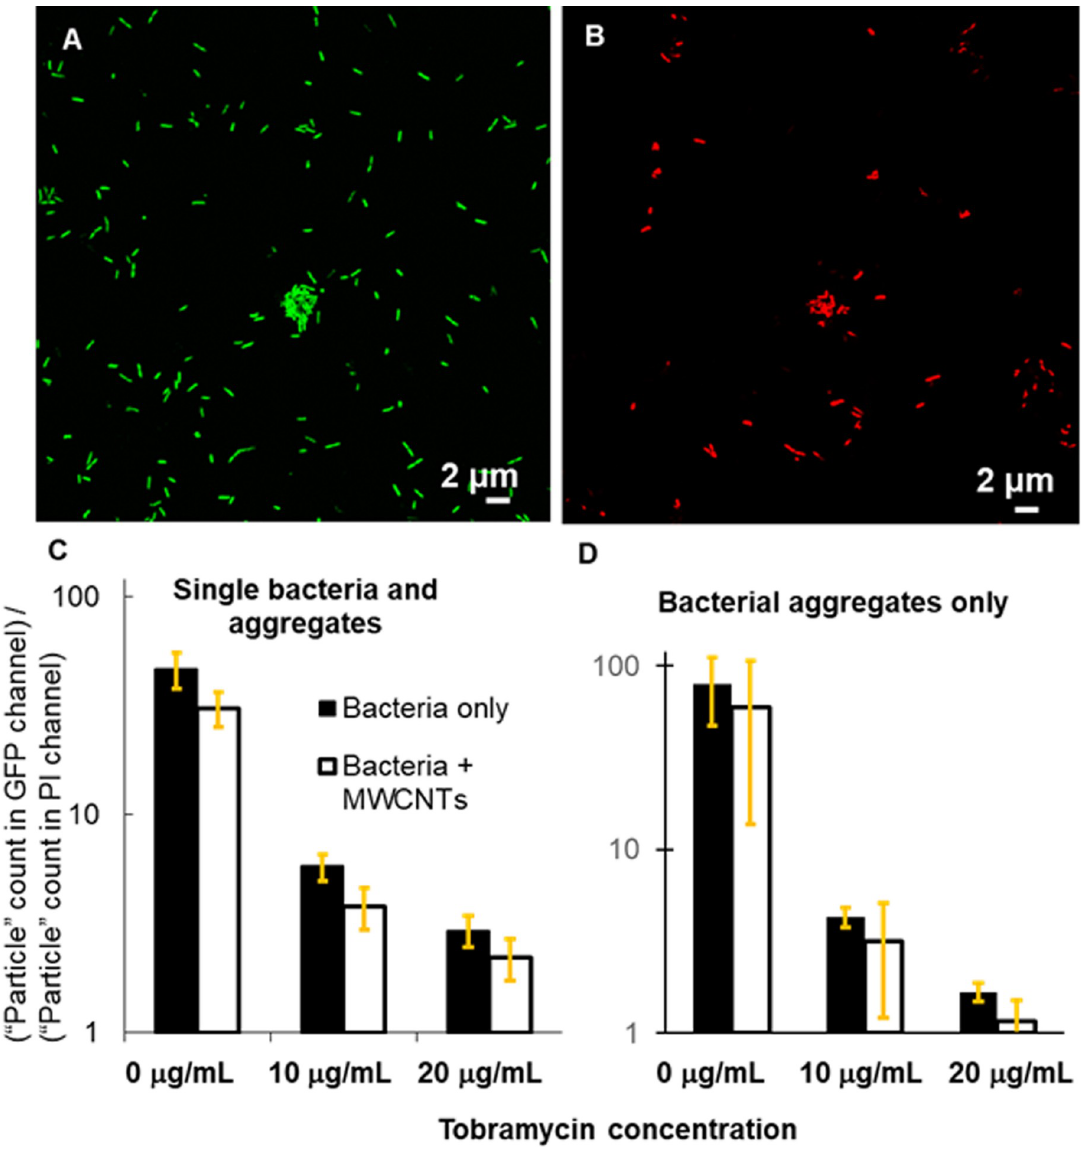
Fig 4. Results from dead-staining of P . aeruginosa cultures. Microscopy images show single bacteria and aggregates after exposure to tobramycin at 20 μ g/mL in (A) the GFP fluorescence channel and (B) the PI fluorescence channel (dead). (C and D) For the three tobramycin concentrations tested, for both (C) single bacteria and aggregates and (D) aggregates only, the surviving fraction of the population is slightly less for the MWCNT-containing sample. However, single-factor ANOVA analysis shows that the differences between the MWCNT-containing samples and the corresponding MWCNT-free samples are not statistically significant. For aggregates and single cells imaged together, five replicate experiments were done for MWCNT-free samples and four for MWCNT-containing samples; for aggregates imaged without single cells, three replicate experiments each were conducted. Error bars are the standard error of the mean.